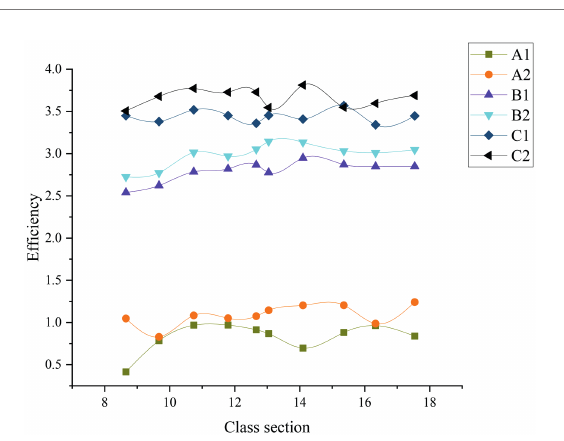
FIGURE 12 The work efficiency of students after the experiment (A1 means ordinary student in Group 1, A2 means ordinary student in Group 2, B1 above-average student in Group1, B2 means above- average student in Group 2, C1 means extraordinary student in Group 1, C2 means extraordinary student in Group 2).